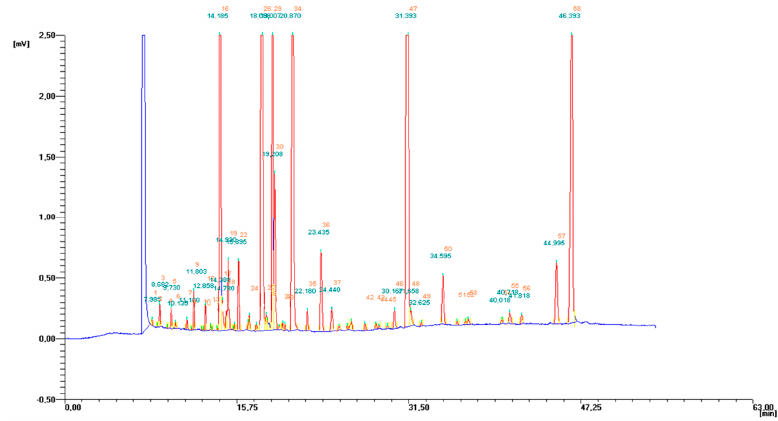
Figure 4. Exemplary GC-FID chromatogram of fatty acid profile in microsomal fraction. Table 3. Fatty acids profile in hepatic microsomes of experimental